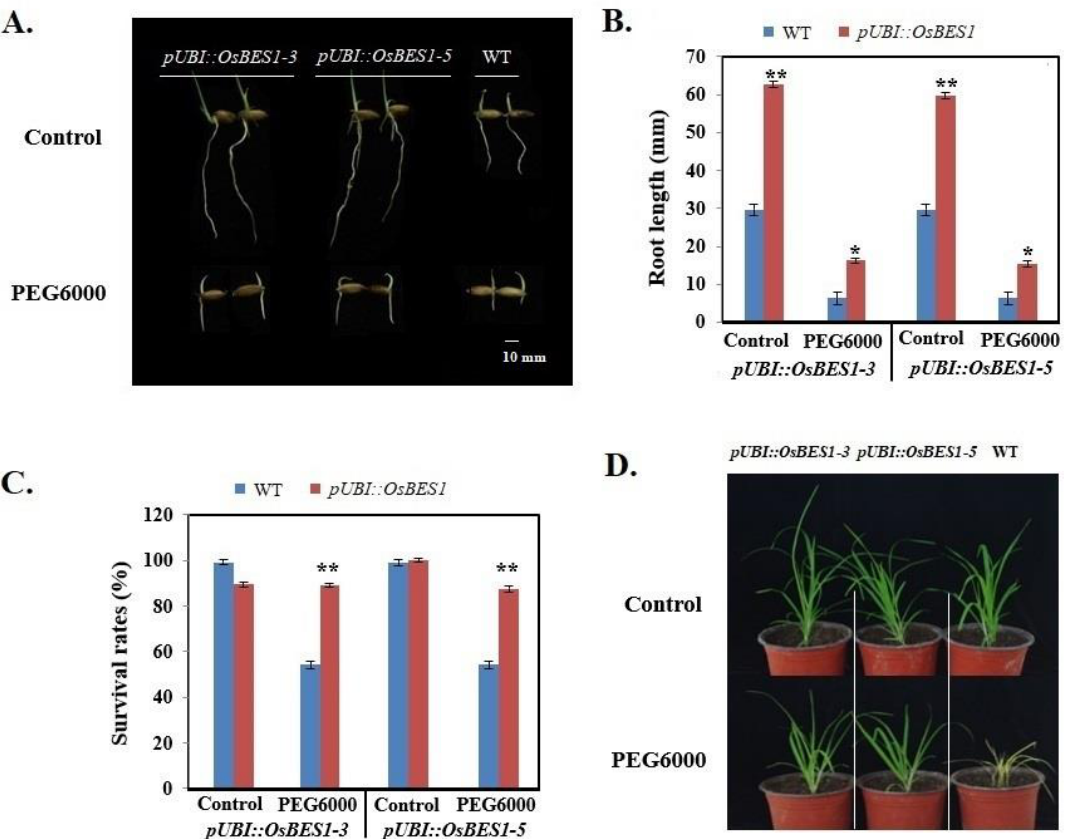
Figure 5. Functional verification in OsBES1 genes under drought stresses. ( A ) The root lengths condition of WT, pUBI::OsBES1-3, and pUBI::OsBES1-5 under control and drought stress. ( B ) Root length bar chart. ‘*’ indicates p < 0.05, ‘**’ indicates p < 0.01. Error bar represents SD. ( C ) The survival rate condition of WT, pUBI::OsBES1-3, and pUBI::OsBES1-5 under control and drought stress. ‘**’ indicates p < 0.01. Error bar represents SD. ( D ) WT, pUBI::OsBES1-3, and pUBI::OsBES1-5 under control and drought stress in